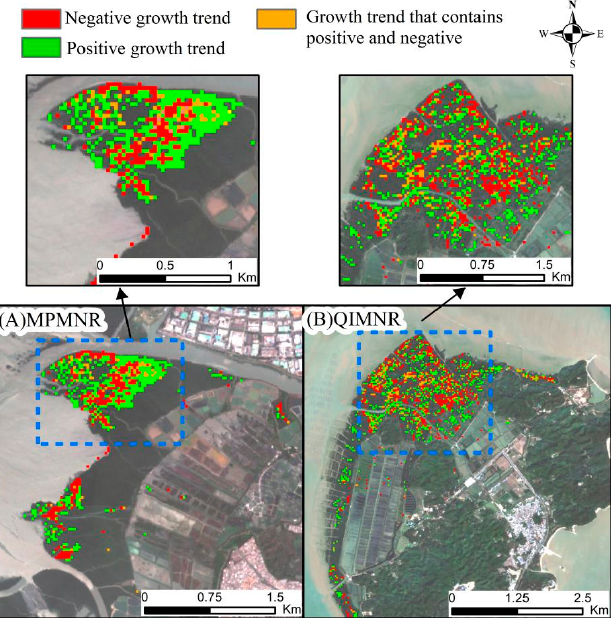
Figure 8. The growth trends of stable mangroves occurred in ( A ) MPMNR and ( B ) QIMNR in 2000–2020.